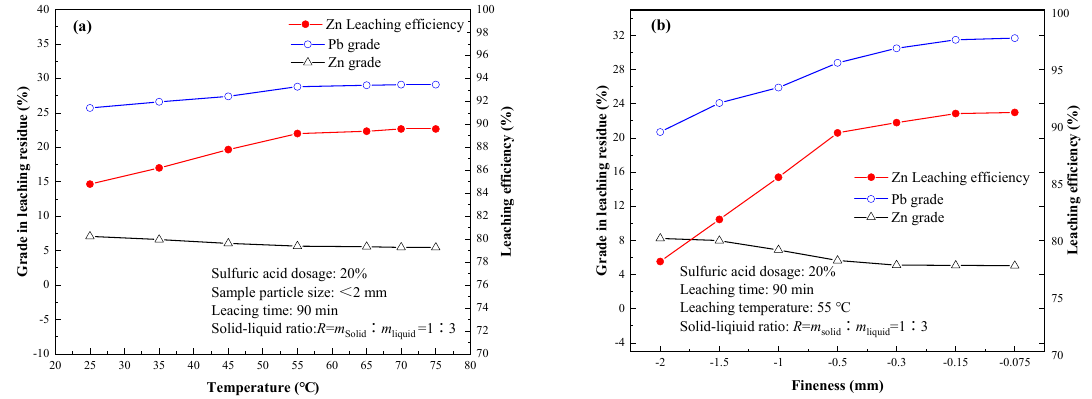
Figure 5. E ff ect of leaching temperature ( a ) and fineness ( b ) on the leaching e ffi ciency of zinc and the metal grades in the leaching Figure 5. Effect of leaching temperature ( a ) and fineness ( b ) on the leaching efficiency of zinc and the metal grades in the leaching residue.